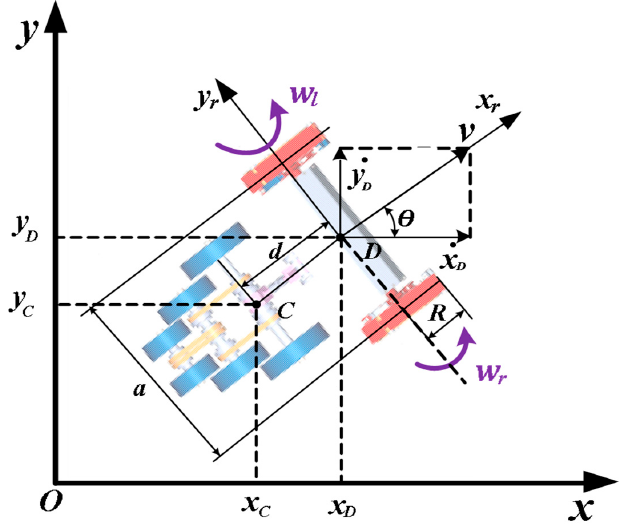
Figure 5. Robot kinematic model.